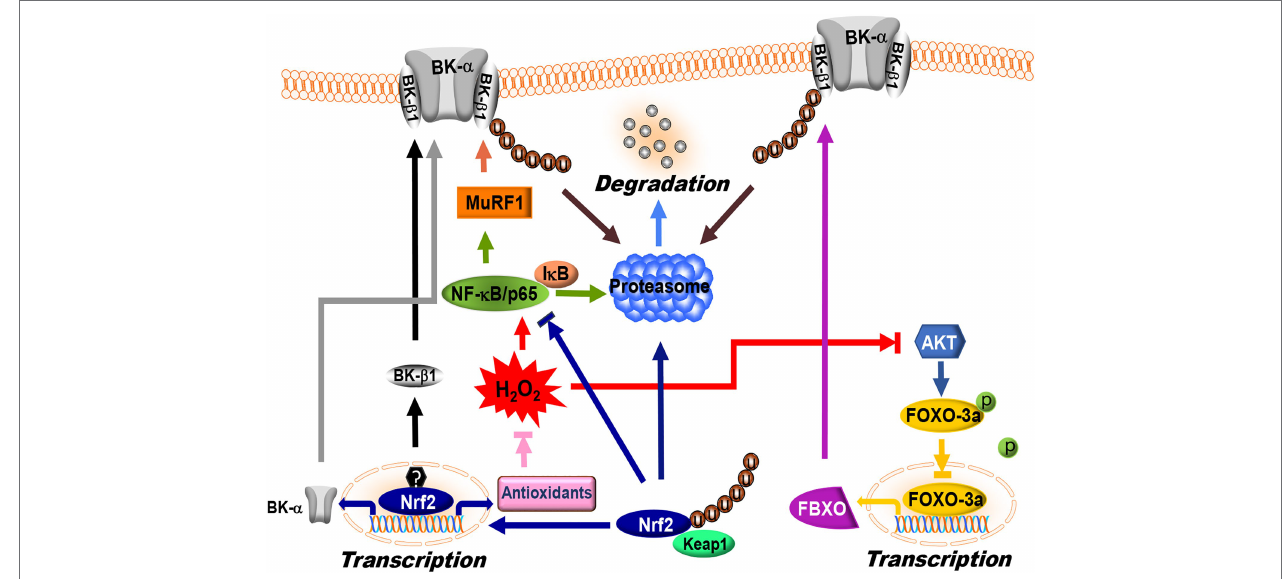
FIGURE 4 | Regulation of BK channel expression by ubiquitin proteasome system (UPS) and nuclear factor erythroid-2-related factor 2 (Nrf2) signaling. FBXO and MuRF1 are the E3 ligases targeting BK- β 1 protein degradation via the UPS in vascular SMCs. FBXO is one of downstream targets of FOXO-3a. FOXO-3a activity is negatively controlled by AKT-dependent phosphorylation, while MuRF1 expression is controlled by NF- κ B/p65. Under baseline conditions, p65 is bound to an inhibitory subunit, I κ B that keeps it sequestered in an inactive state in the cytoplasm. Phosphorylation of I κ B by I κ B kinase promotes I κ B degradation through the UPS, which in turn releases p65 and facilitates nuclear translocation. Under hyperglycemic conditions, overproduction of ROS inhibits AKT and activates NF- κ B/p65, which in turn promotes FBXO and MuRF1 expression, leading to BK- β 1 ubiquitination and accelerated degradation in vascular SMCs. Nrf2 is the master regulator of the antioxidant response. Under normal conditions, each molecule of Nrf2 interacts with two molecules of Keap1 resulting in UPS-mediated degradation. ROS modifies specific cysteine residues in Keap1 and releases Nrf2 from binding with Keap1. The unbound Nrf2 translocates into the nucleus and binds to the promoter region of target genes. Nrf2 directly upregulates BK- α mRNA expression via binding to the promoter region of KCNMA1 . However, BK- β 1 mRNA expression is not regulated by Nrf2 but by other transcription factor(s). In DM, Nrf2 expression and function is significantly downregulated, leading to a decrease in BK- α expression through reduced transcription and a decrease in BK- β 1 expression through accelerated UPS degradation. The symbols “u” and “p” represent protein ubiquitination and phosphorylation,